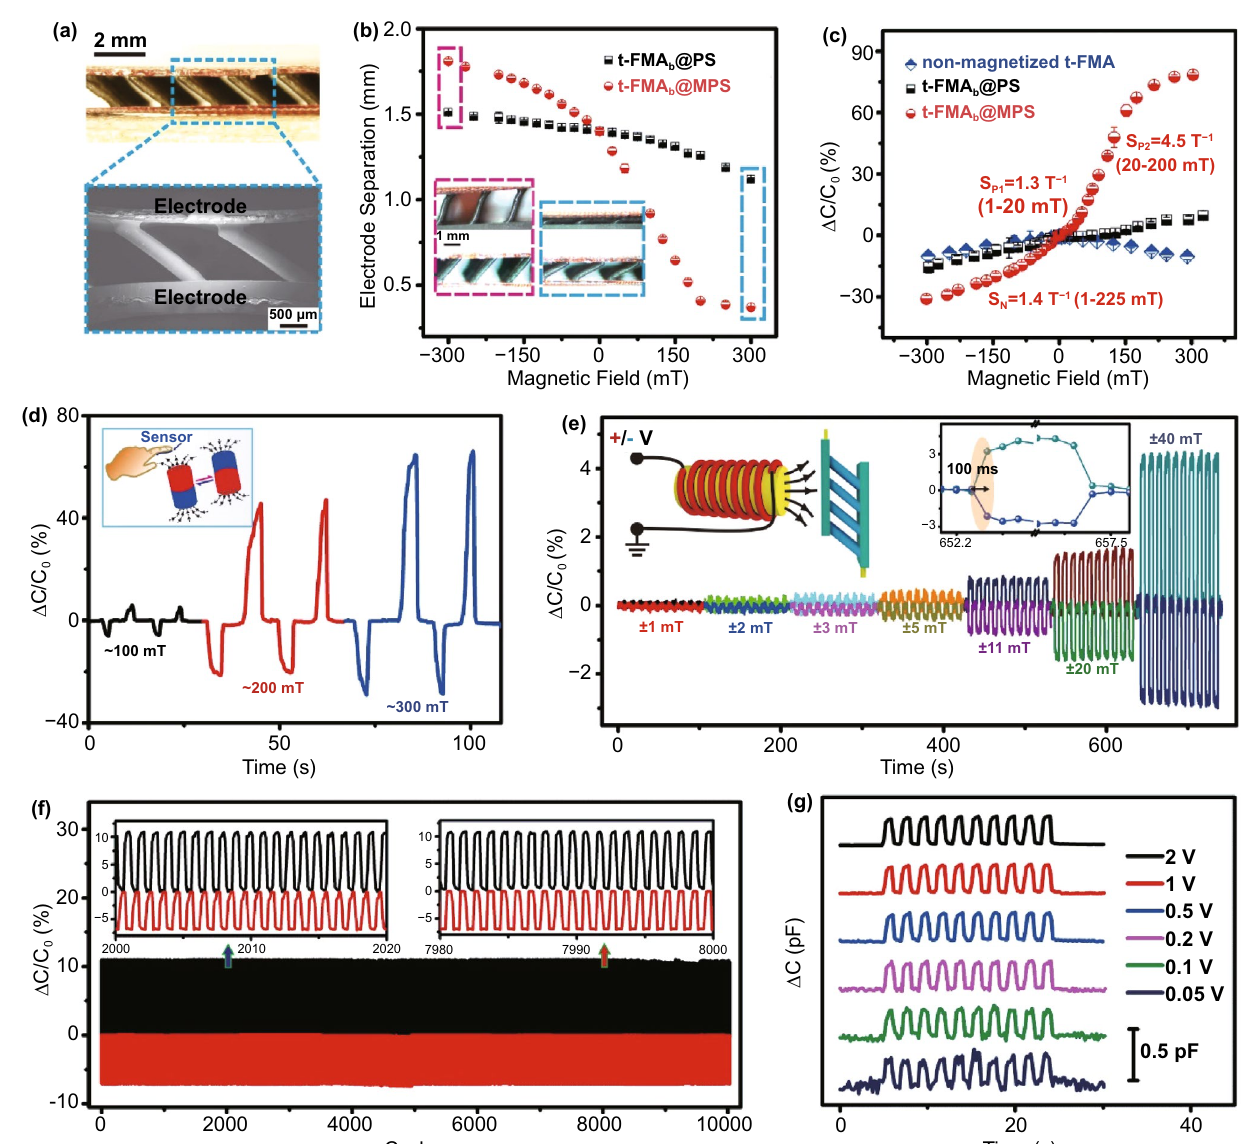
Fig. 3 a Side-view of optical and SEM images of the assembled sensor based on t-FMA b @MPS. b Variations of the electrode separation of the assembled device based on t-FMA b @PS and t-FMA b @MPS under magnetic fields. c Relative capacitance variation of the sensor based on t-FMA b @PS, t-FMA b @MPS and non-magnetized t-FMA b @MPS under magnetic fields. d Real-time response of the optimized sensor to differ- ent magnetic fields. e Stability of the sensor under different magnitudes of electromagnetic field. f Long-term stability of the sensor under the periodic electromagnetic field of ~ 65 mT for over 10,000 cycles. g Electric response of the sensor to electromagnetic field of ~ 65 mT under dif- ferent operating